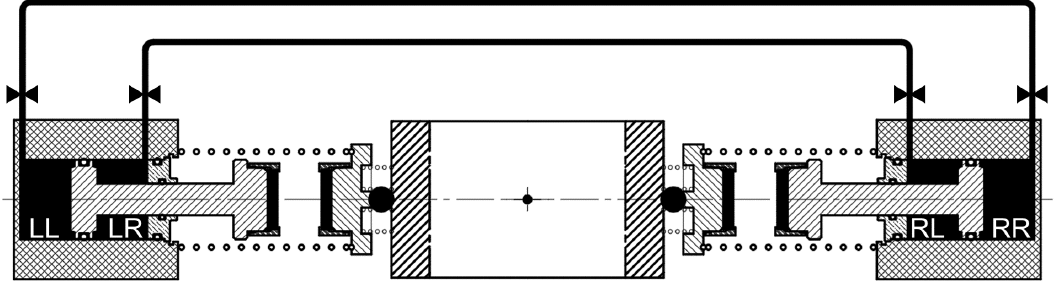
Figure 4. Schematic diagram of the hydraulic connection between opposing cylinders.